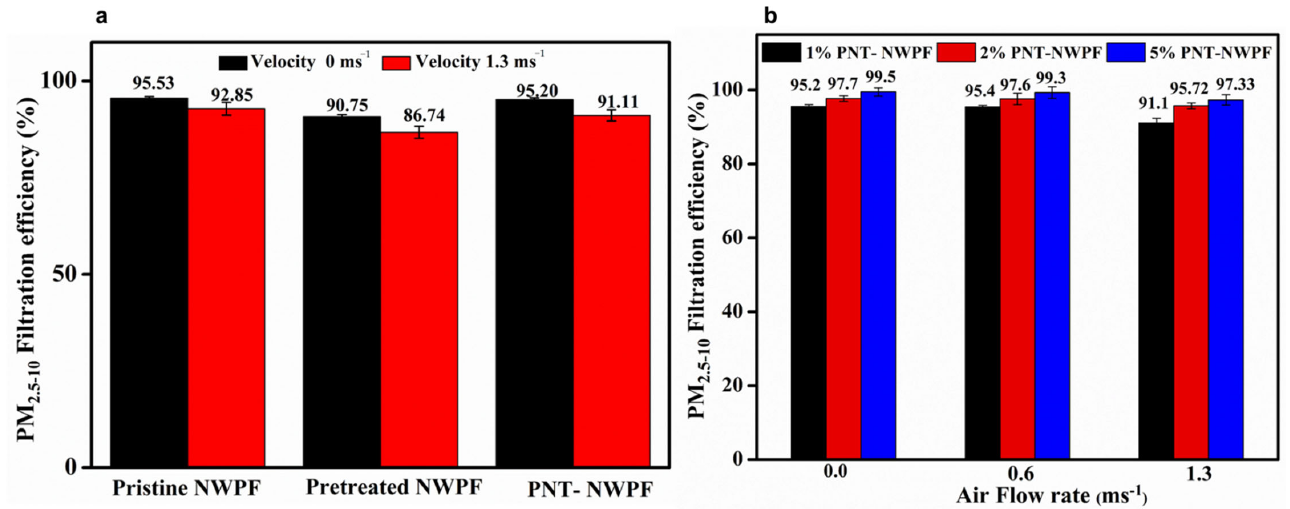
Figure 5. ( a ) Fine dust filtration efficiency at different air velocities. ( b ) Effect of catalyst loading efficiency. The undesired effect of the pretreated NWPF, caused by excess negative charge, is